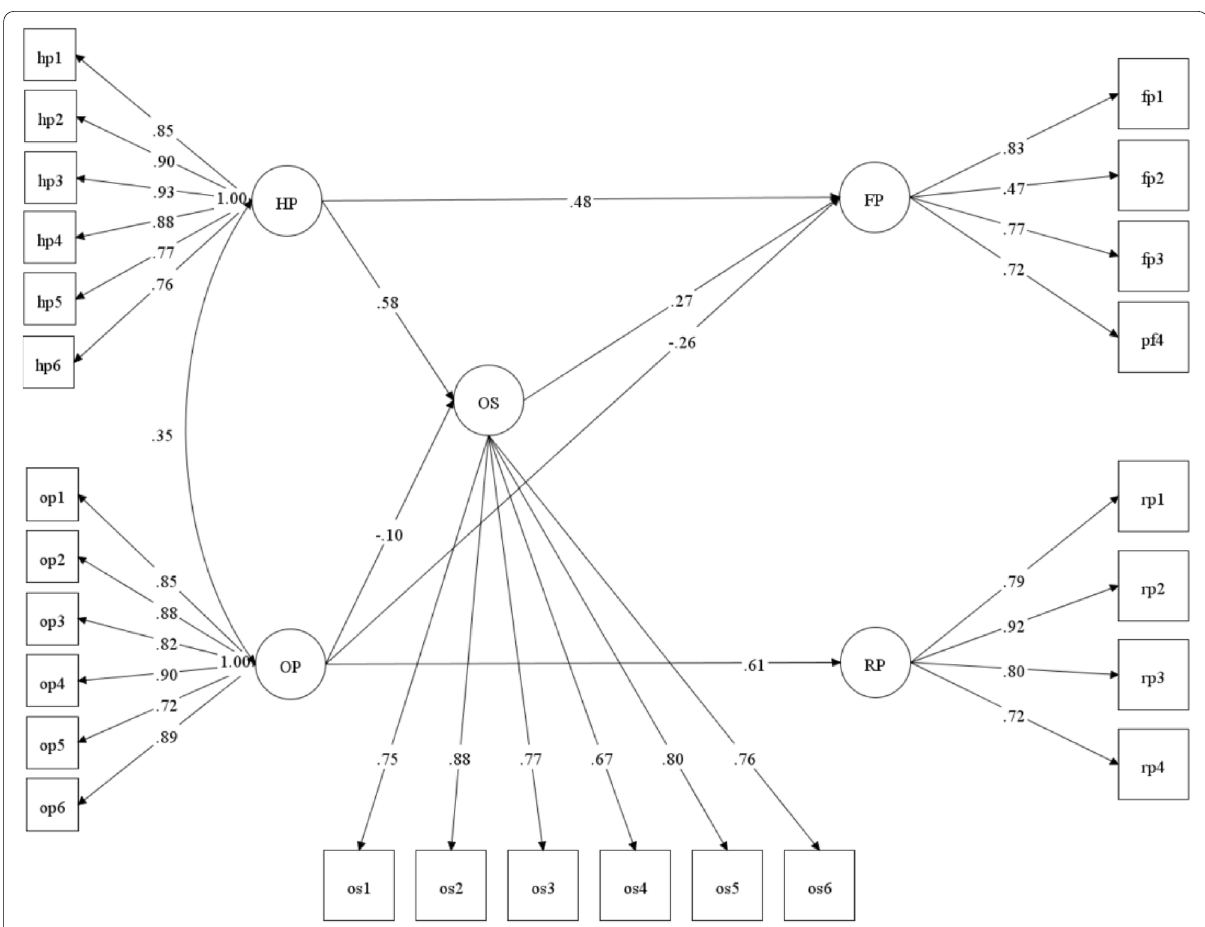
Fig. 2 Theoretical model of passion as a predictor of persistence mediated by occupational self-efficacy. Note: FP persistence, OS occupational self-efficacy, HP =